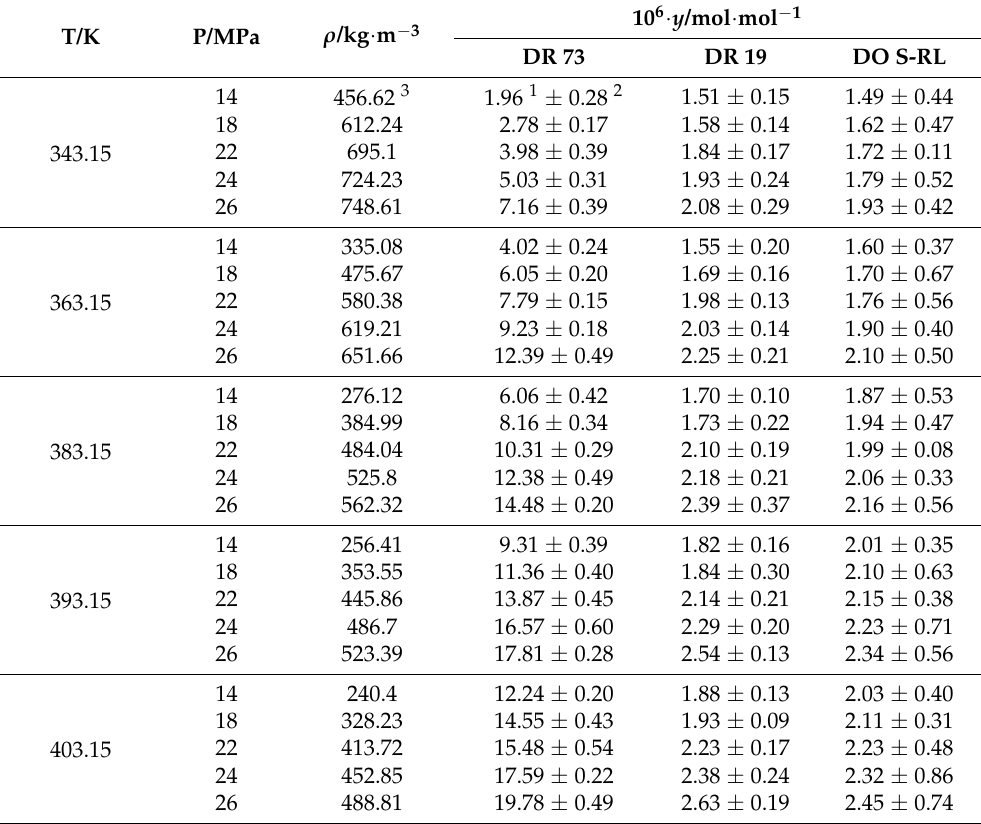
Table 2. Solubility data for crystalline DR 73, crystalline DR 19 and crystalline DO S-RL in sc-CO 2 , and the density of sc-CO 2